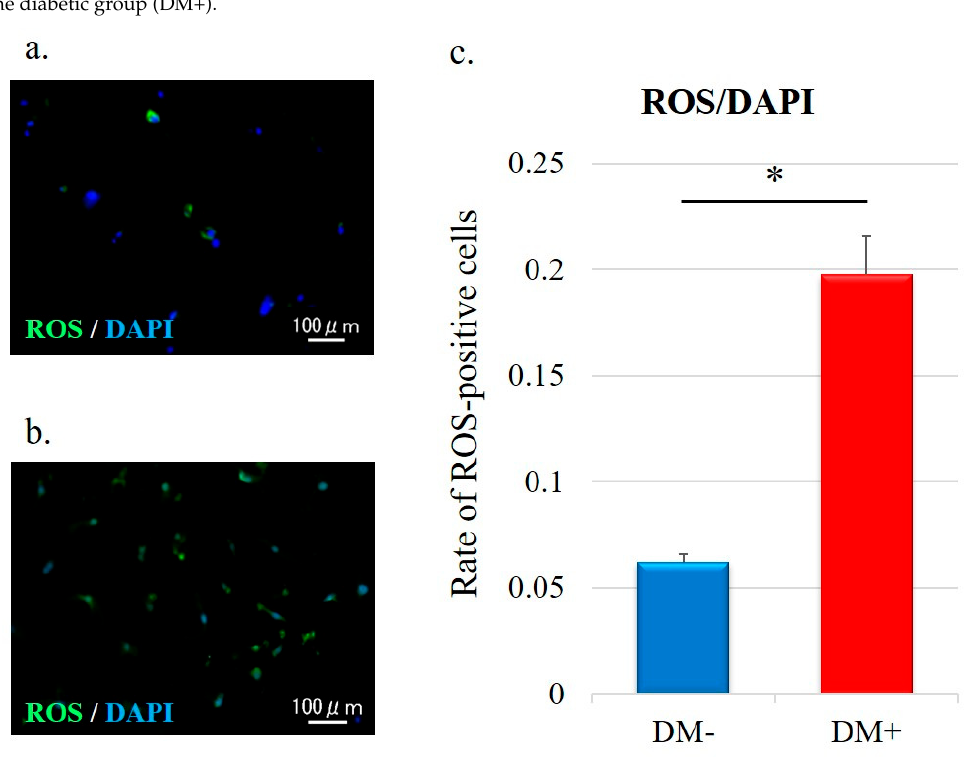
Figure 4. Representative immunofluorescence images of the detection of ROS levels in rotator-cuff-derived cells: ( a ) non-diabetic controls and ( b ) diabetic group. DCFH–DA staining (green) is indicative of the accumulation of reactive oxygen species (ROS) in rotator-cuff-derived cells; the nuclei are counterstained with 4 ′ ,6-diamidino-2-phenylindole (DAPI; blue). ( c ) Relative quantification of the ROS-positive cells (refers to Figure 4a,b). ROS-positive cells and DAPI-positive cells in four rectangular areas (0.75 mm × 1.0 mm) on each slide were counted and their mean values were analyzed. The ROS-positive cells rate (number of ROS-positive nuclei/DAPI-positive nuclei) is given as the mean of the four areas. Data are presented as the mean ± SD. The independent t -test was performed for determining significant differences: * p < 0.001. ROS, reactive oxygen species; DAPI, 4 ′ ,6-diamidino-2-phenylindole.